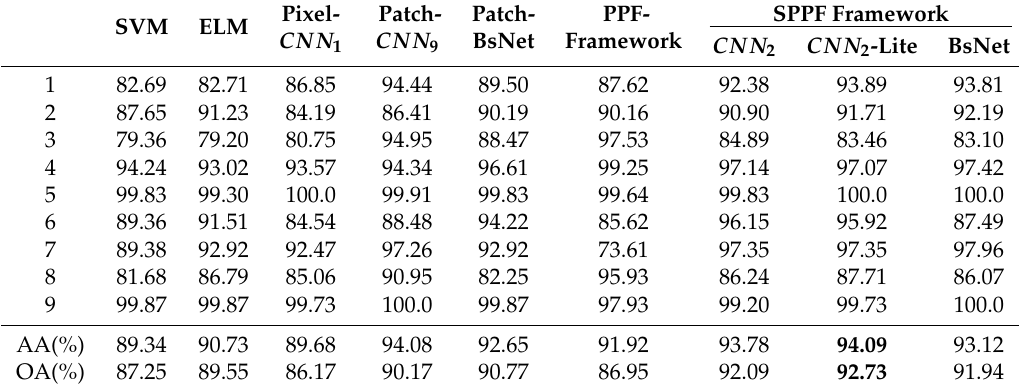
Table 9. Classification results on the Pavia University dataset (accuracy shown in percentage).